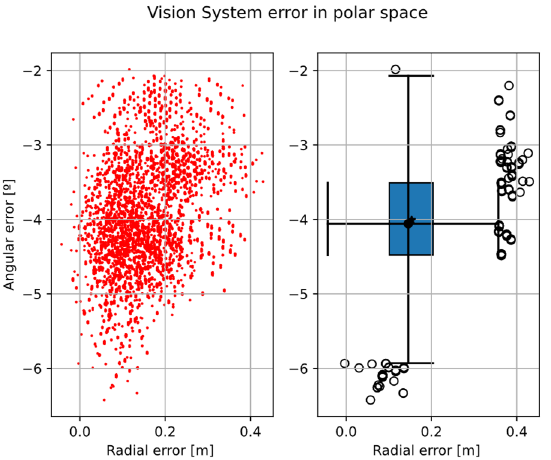
Figure 11. Vision system error in polar space. Left, scatter distribution; Right, 2D boxplot with 1.5 whis.